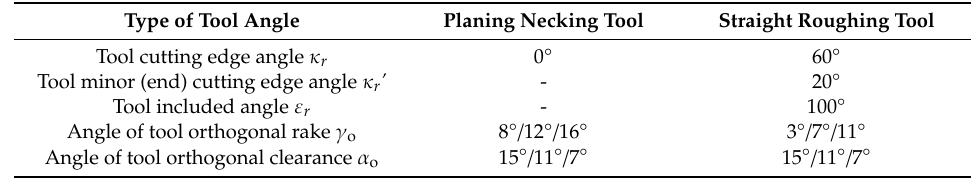
Figure 4. Straight roughing tool, ( a ) λ s = 0°; ( b ) λ s = 10°; ( c ) λ s = 20°. Table 1. Changes in the angle values.